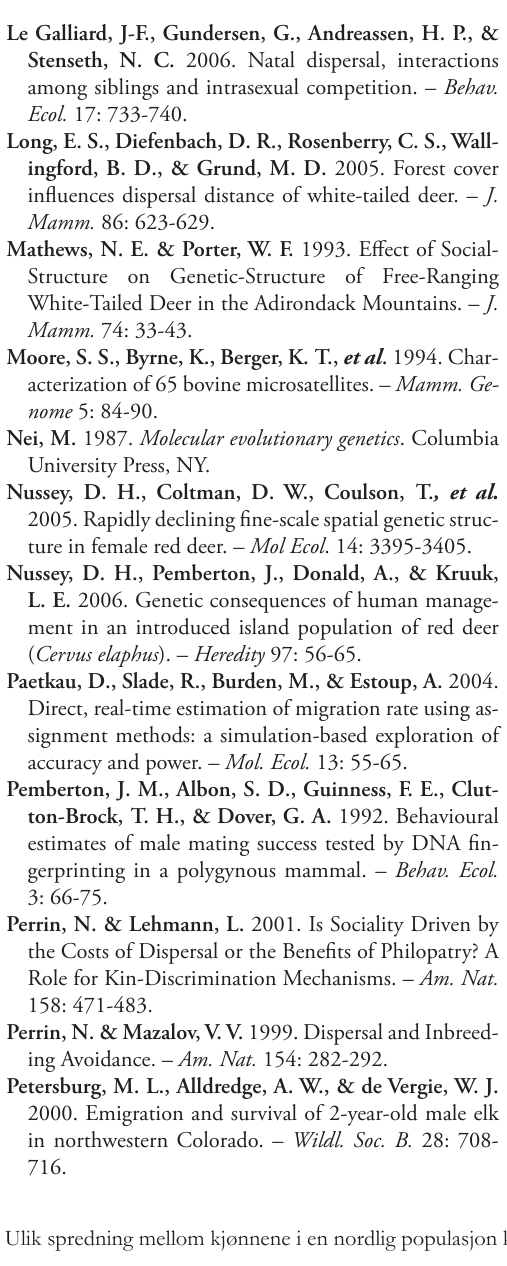
Abstract in Norwegian / Sammendrag : Hos de fleste arter pattedyr skjer spredning oftest hyppigere og over lengre avstand- er blant hanndyra enn blant hunndyra, og i mange polygame arter klovdyr vil hjemmekjærhet og matrilineære grup- peringer blant hunndyra medføre en småskala genetisk strukturering. Ved å undersøke for kjønnsrelaterte forskjeller i fordelingen av allelfrekvensene til mikrosatellitter i arvestoffet har vi belyst hvorvidt dette er tilfellet hos en geografisk ekspanderende nordlig klovdyrpopulasjon. Den norske hjortepopulasjonen ( Cervus elaphus atlanticus ) har det siste år- hundret vokst betraktelig i antall og geografisk utbredelse etter at bestanden ble drastisk redusert for 300 til 100 år underbestander. Blant disse underbestandene av hjort var de sammenlagte F -verdiene 0,067 (SE=0,014) for st